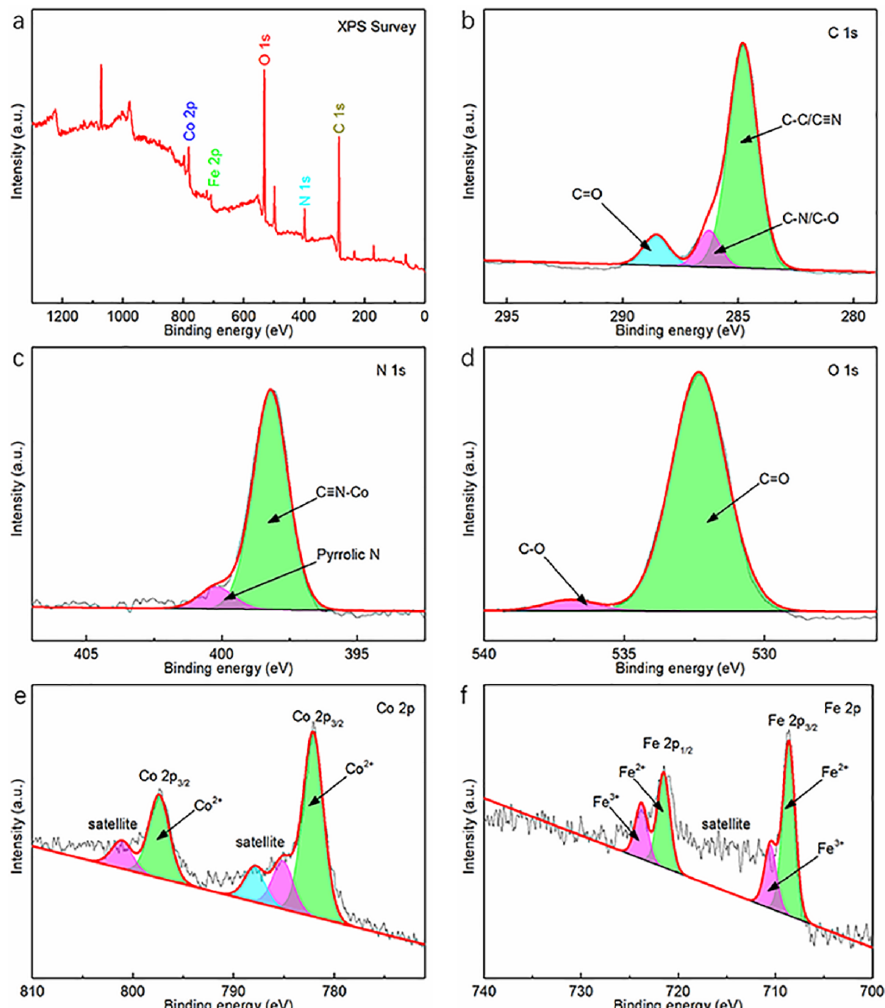
Figure 3. ( a ) Survey XPS spectrum of the fresh Co-Fe-PBA@rGO composite; high-resolution XPS spectra of ( b ) C 1s peaks, ( c ) N 1s peaks, ( d ) O 1s peaks, ( e ) Co 2p peaks and ( f ) Fe 2p peaks.